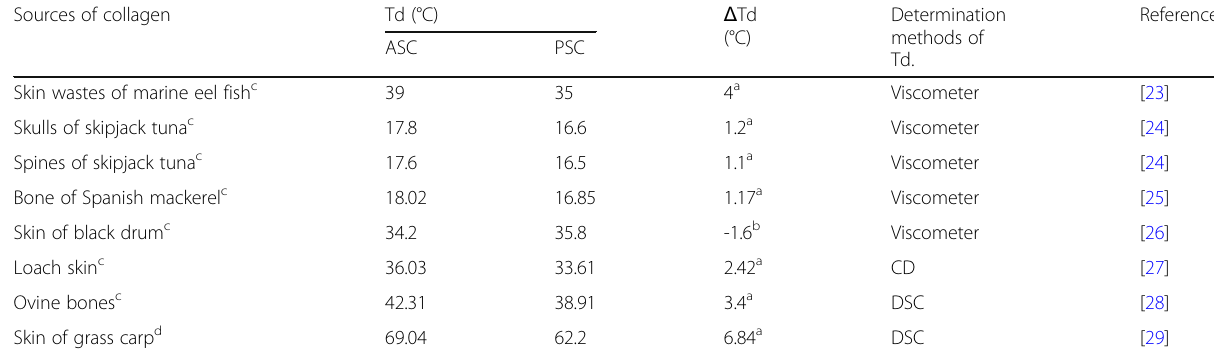
Table 1 The difference in denaturation temperature/ Δ Td > 1°C between ASC and PSC Sources of collagen Td (°C) Δ Td